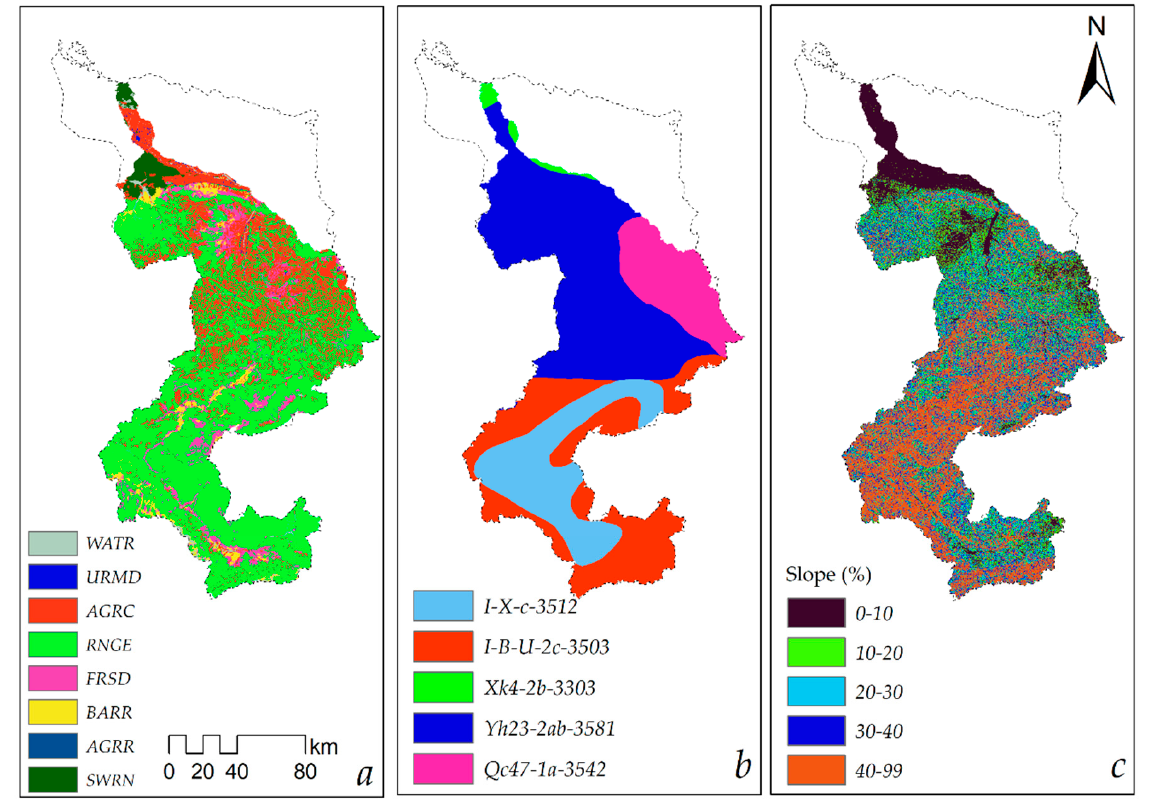
Figure 2. The input for the HRU definition. ( a ) Land cover map of the BRB, ( b ) the soil-type map from the FAO/UNESCO soil map of the world, ( c ) the slope map of the BRB created from the DEM.